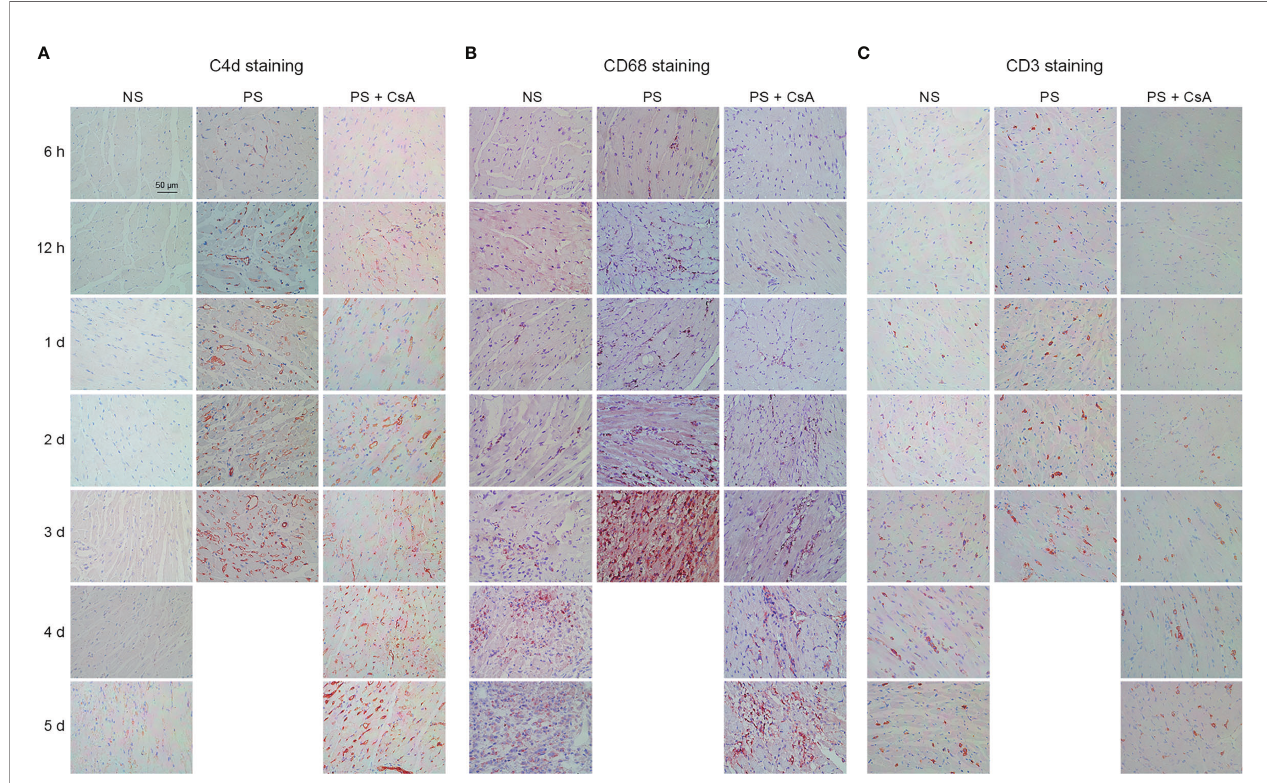
FIGURE 2 | C4d, CD68, and CD3 staining of cardiac allografts. C4d (A) , CD68 (B) , and CD3 (C) staining of cardiac allografts in the NS, PS, and PS + CsA groups at different timepoints after transplantation (n = 5/time point). Magni fi cation: 400×; NS, non-presensitized; PS, presensitized; PS + CsA, presensitized plus cyclosporine